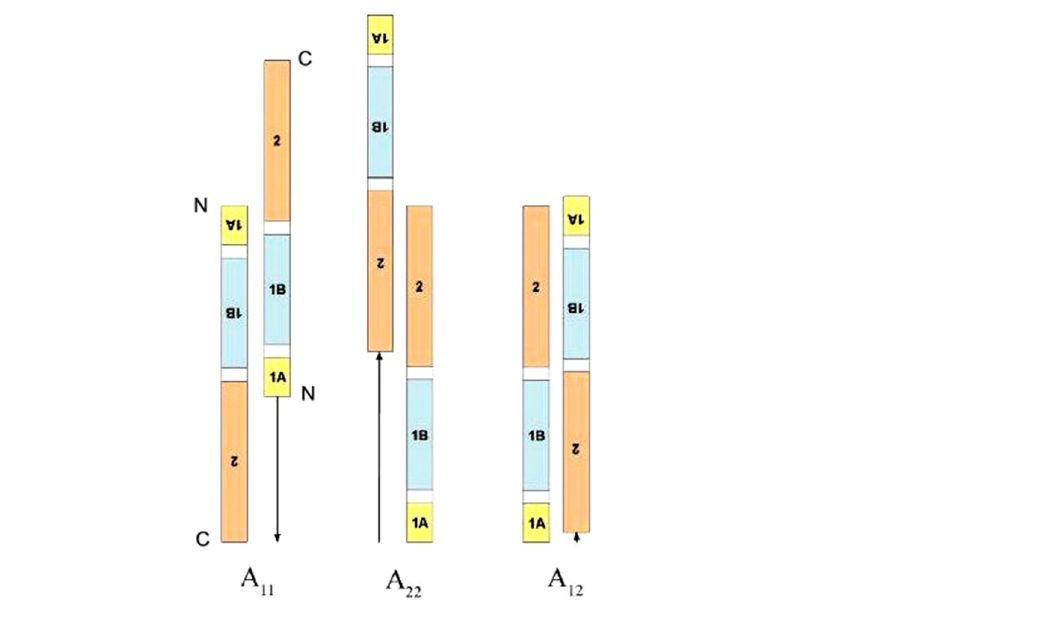
Figure 11. In total, three modes of molecular assembly are found in IF [82,87]. These are termed A 11 , A 22 , and A 12 and involve the approximate axial alignment of antiparallel 1B segments, antiparallel 2 segments and antiparallel rod domains, respectively. The axial staggers for each mode are measured from the N-terminus of segment 1A in an up-pointing molecule. Figure reproduced from [71] with permission of Elsevier.